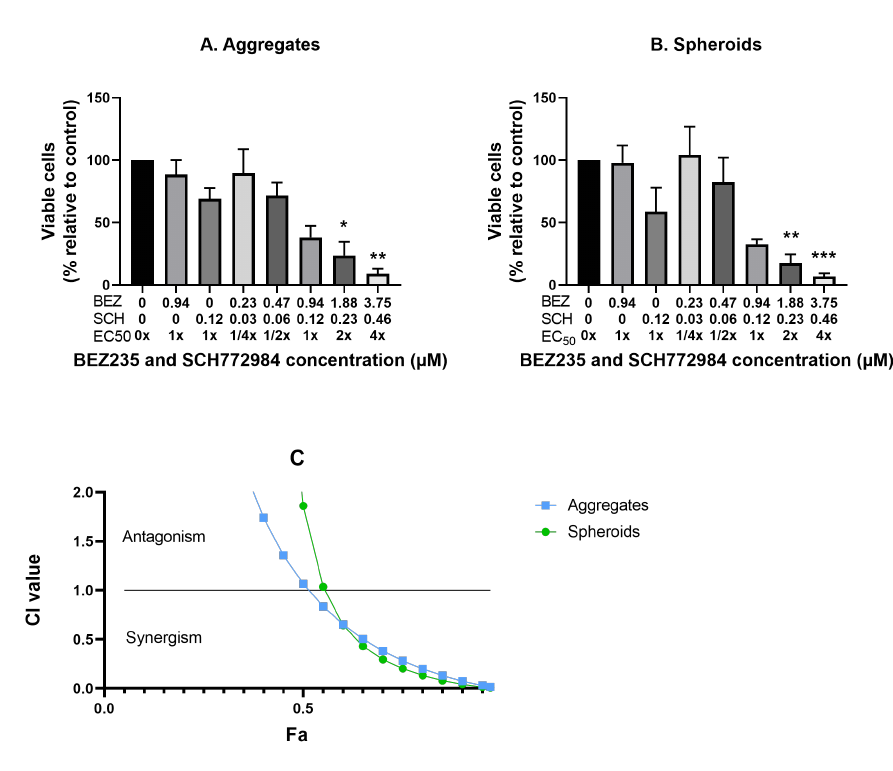
Figure 7. The effect of the combination of BEZ235 and SCH772984 cell proliferation in OV-90 suspension aggregates ( A ) and hanging drop spheroids ( B ). OV-90 aggregates and OV-90 spheroids were established for 7 days followed by 72 h exposure to the inhibitor combination at 1/4, 1/2, 1, 2 and 4 × EC 50 . Proliferation was significantly reduced in OV-90 aggregates by the 4 × EC 50 combination and in OV-90 spheroids at the 2 and 4 × EC 50 combinations. CI values indicate a synergistic interaction in both OV-90 aggregates and spheroids ( C ). Data are expressed as mean ± SEM (n = 4). Statistical significance is at p < 0.05 and is in comparison to the control. The statistically significant differences are indicated as p < 0.05 (*), p < 0.01 (**) and p < 0.001 (***), as determined by one-way ANOVA with Tukey’s multiple comparison test on log transformed data.